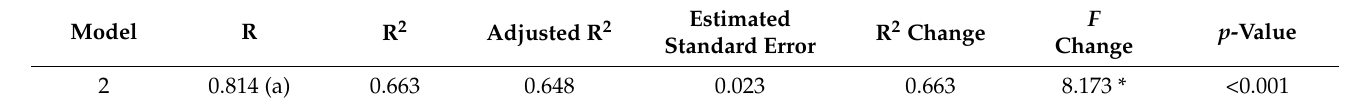
Table 9. Summary of the social support of the EGa for multiple regression model 2.